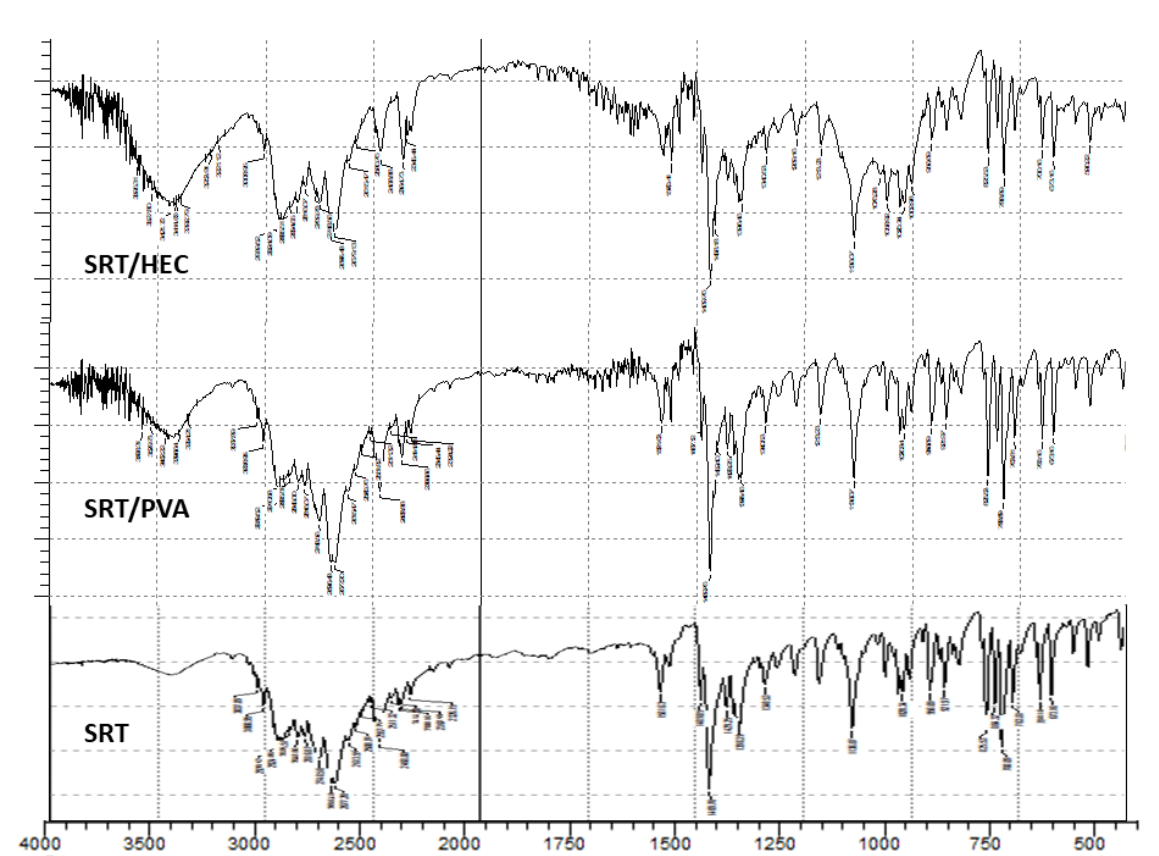
FIGURE 3 a & b - FTIR of SRT and its physical mixtures with different